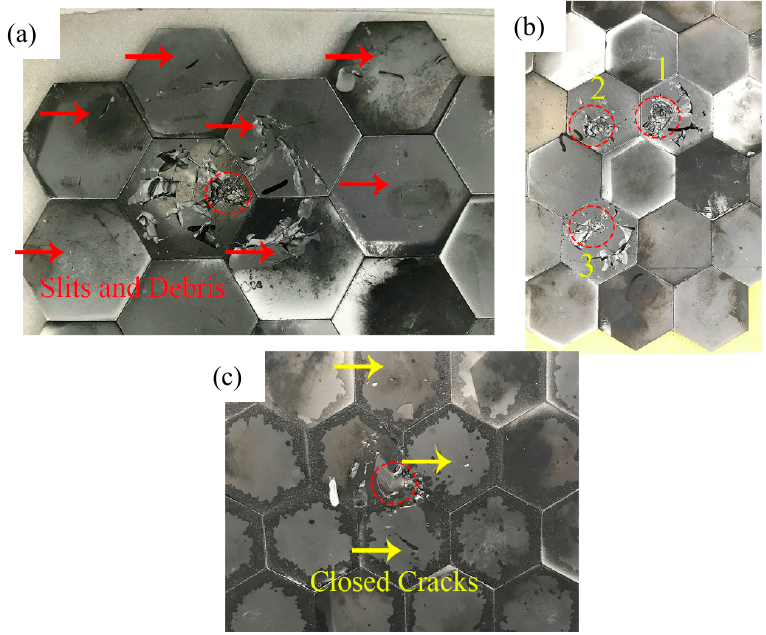
Figure 4. The first impact damage of the three structures: ( a ) Structure 1; ( b ) Structure 2; ( c ) Structure 3.